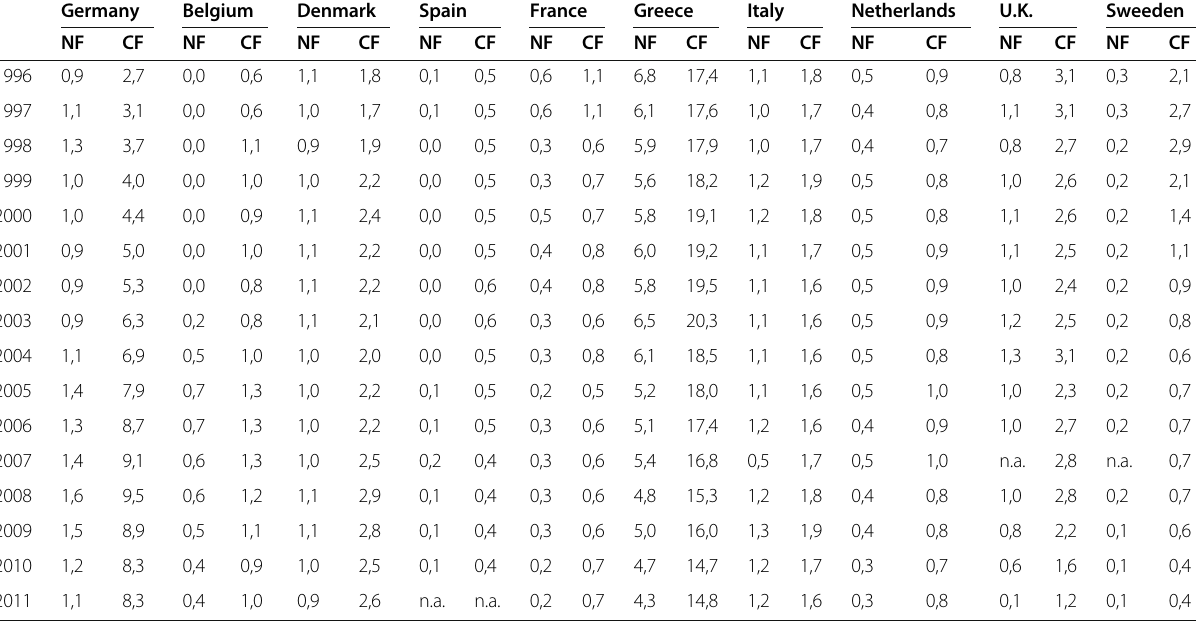
Table 3 Trend in the share of the main EU maritime countries in the world fleet (national flag and controlled fleet in DWT), 1996 – 2011 (in %)